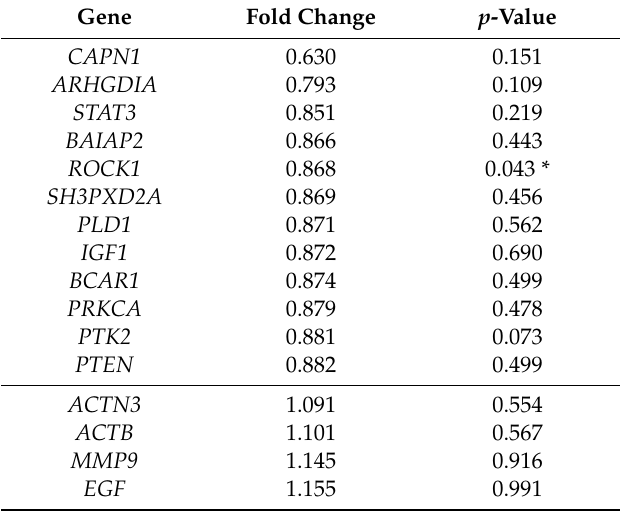
Table 1. Di ff erentially expressed genes upon rhTFF3 stimulus (RT 2 Profiler PCR Array Human Cell Motility). * p <